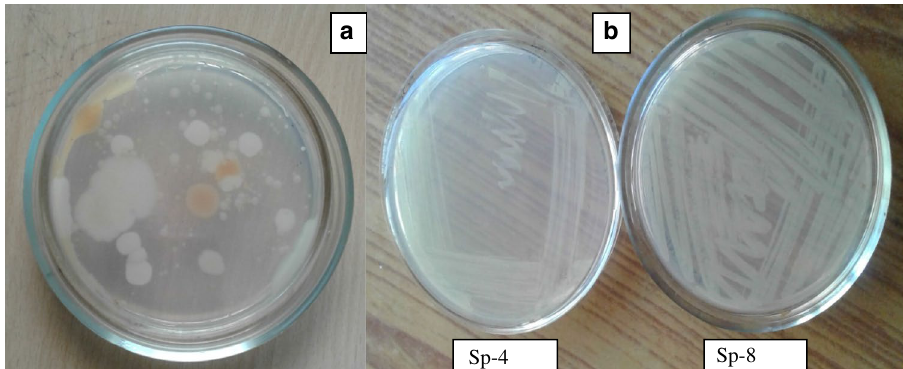
Fig. 1 a Spread plate, b streak plate of SP-4 and SP-8